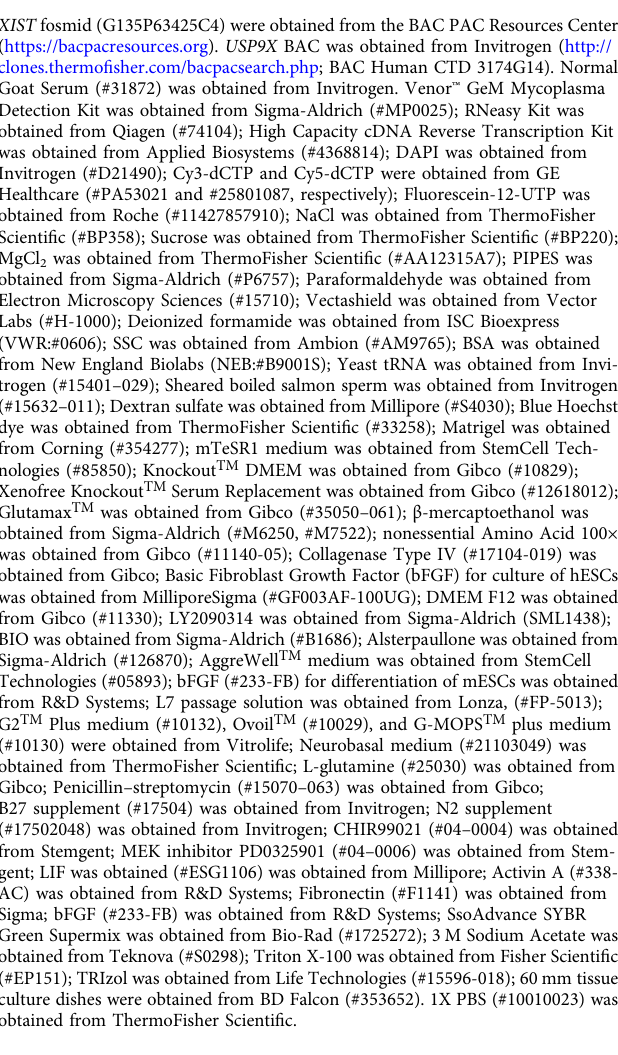
Fig. 10 GSK-3 Inhibition and Loss of Xist RNA Coating in Female mEpiSCs. a Strategy to test the impact of GSK-3 inhibition on Xist RNA coating in mEpiSCs. b Representative RNA FISH images of colonies with high, intermediate, and low percentage of Xist RNA coating (green). Nuclei are stained blue with DAPI. At least ten nuclei were counted per colony in mEpiSC RNA FISH quanti fi cation. Scale bars are ~100 microns. c Percentage of nuclei with Xist RNA coating in three independent mEpiSC lines cultured with and without the GSK-3 inhibitor CHIR99021 (CHIR; 3 μ M). All three mEpiSC lines cultured with CHIR lost a signi fi cant proportion of Xist RNA coating compared to mEpiSCs cultured without CHIR (general linear model comparison, p < 0.001). d Model of direct or indirect repression of human XIST and mouse Xist expression. Conserved mouse and human Xist / XIST sequences upstream of the Xist / XIST TSSs shown, with putative TCF binding motifs in red and surrounding conserved sequence in blue. At least ten nuclei were counted per colony for mEpiSC RNA FISH quanti fi cation. The total number of colonies quanti fi ed at each passage range between 15 and 25 and are cataloged in source